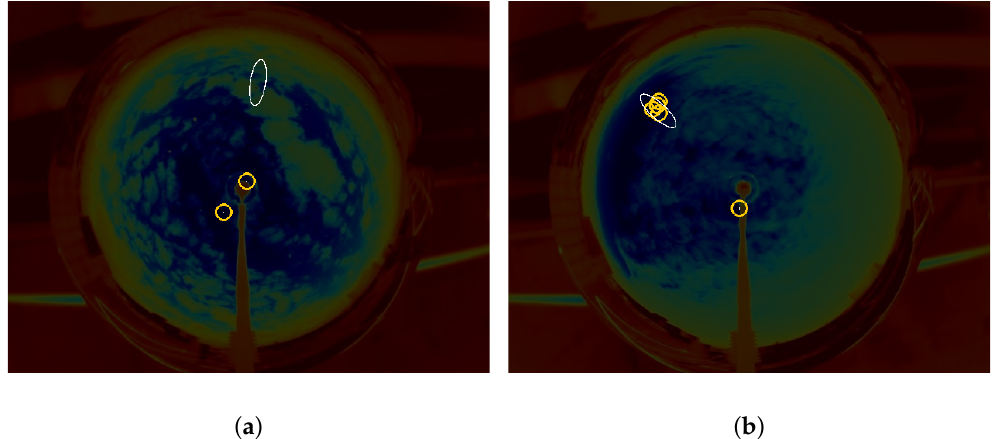
Figure 11. Other possible cases for Sun identification: ( a ) no spot in the ellipse and ( b ) several spots in the ellipse.